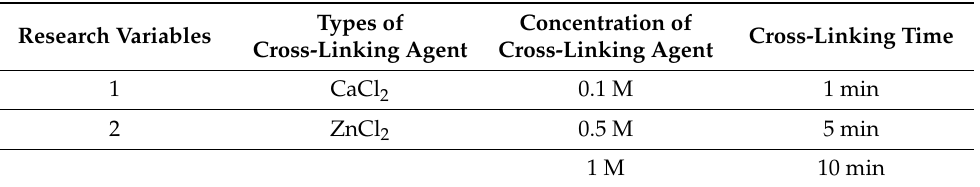
Table 2. Factors and variables in this study.